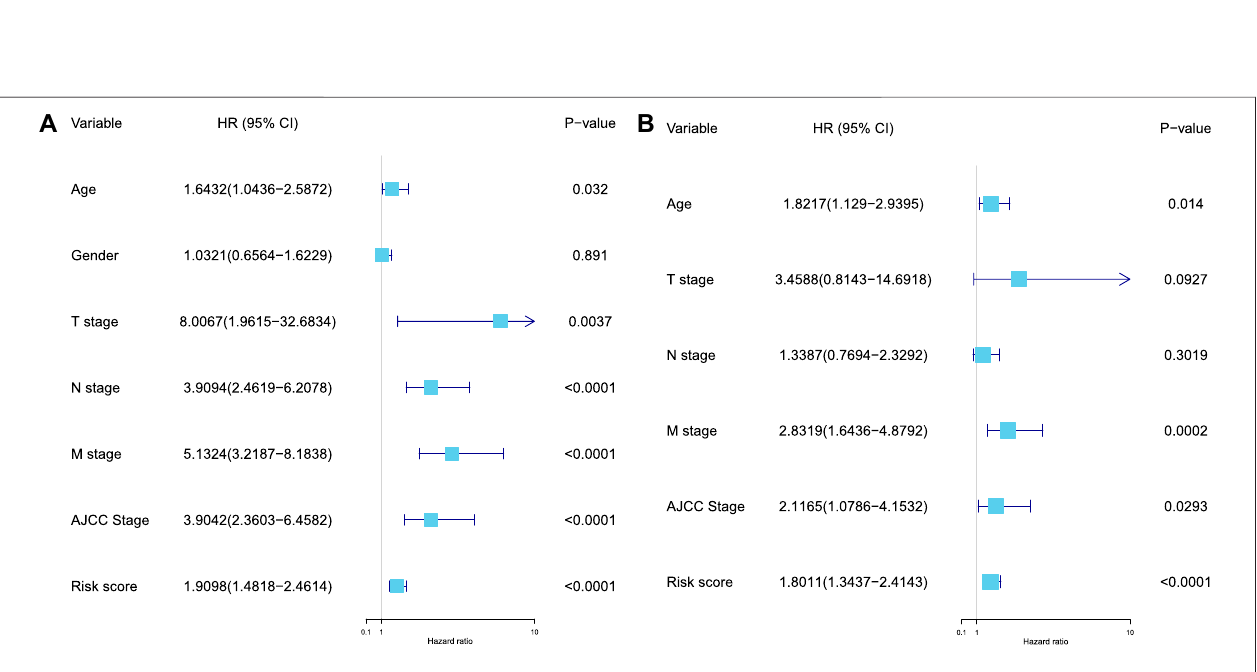
FIGURE 6 | Validation of the independent predictive power of the model. (A) Univariate Cox regression analysis of the prognostic variables in the whole set. (B) Multivariate Cox regression analysis of the prognostic variables (age, T stage, N stage, M stage, AJCC stage, and RS) in the whole set.